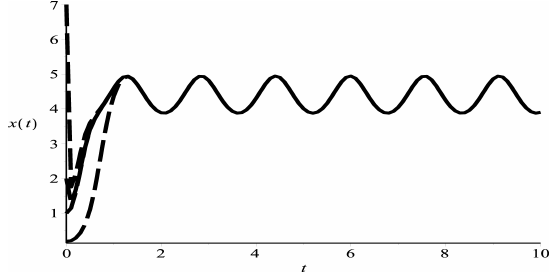
Fig. 1. Dynamic behavior of the first component x.t/ of the solution .x.t/;y.t// of system (59) with the initial conditions